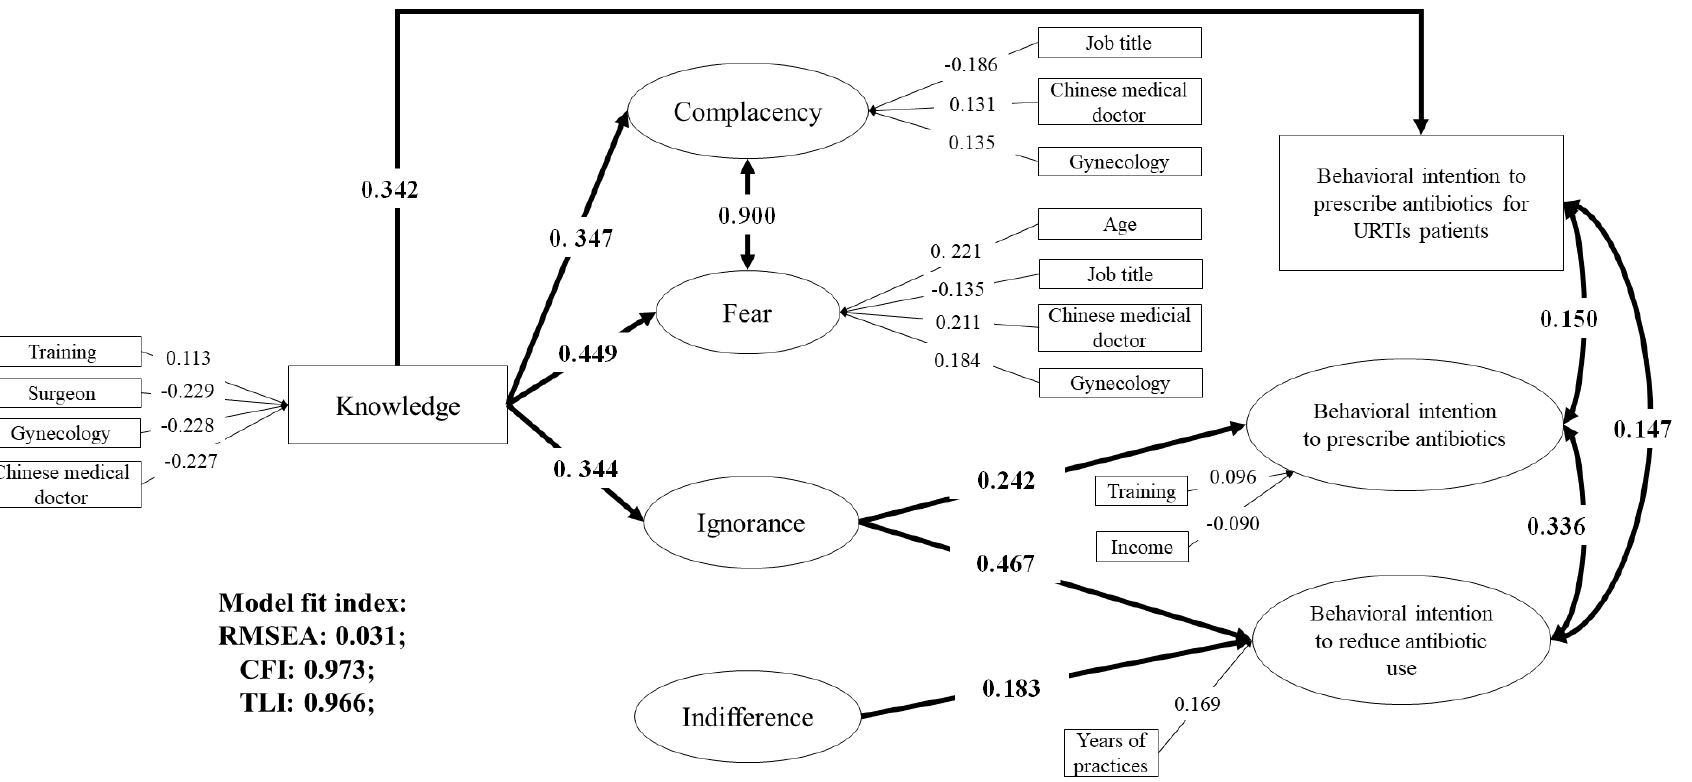
Figure 3. Structure equation model on knowledge, attitudes, and behavioral intentions toward antibiotic prescriptions. Only significant pathways ( p < 0.05) were reported with standardized path coefficients.